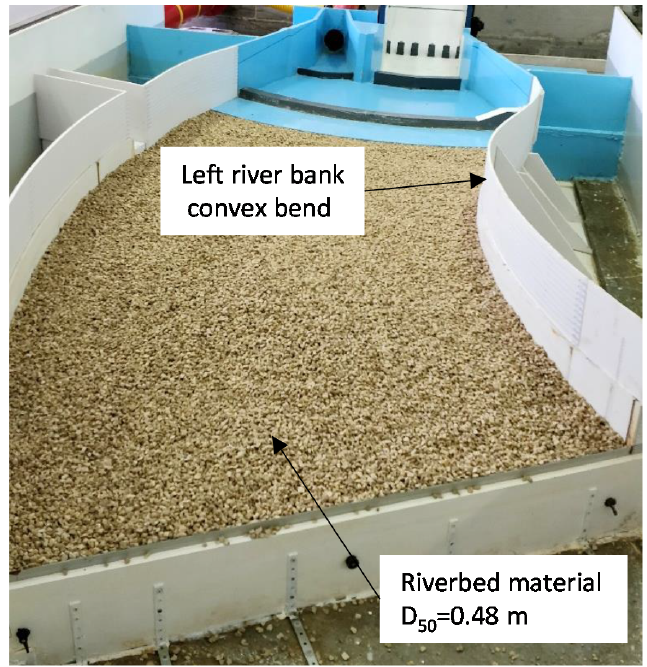
Figure 5. Riverbed configuration of the first set of the physical model tests performed, corresponding to the current real layout.